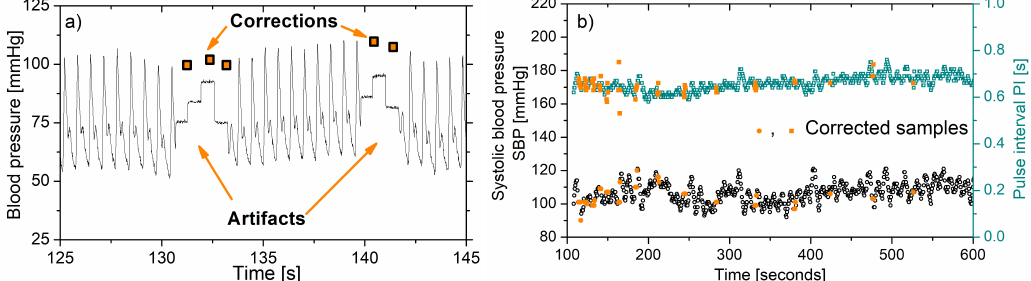
Figure 7. Artifacts in portable blood pressure monitor: ( a ) Typical artifacts with the corresponding automatic corrections ( b ) Systolic blood pressure and pulse interval signal samples with embedded corrections. The blood pressure waveforms were recorded by Portapres monitor (http://www.finapres. com/Products/Portapres) at Bežanijska Kosa Hospital, with 100 Hz sampling frequency. The